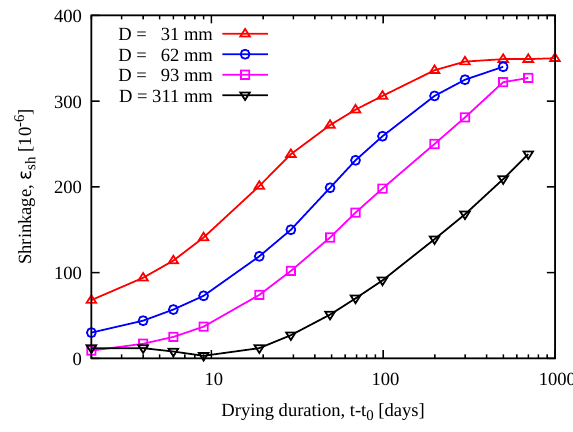
Figure 2. The experiment of L’Hermite (data adapted from [16]) shows incomplete drying shrink- age of the largest specimen with D = 311 mm. Such measurements were not discarded but are denoted by empty symbols in Fig.